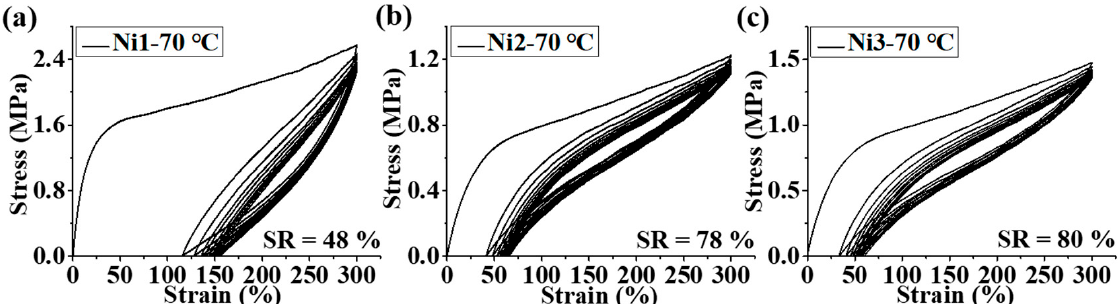
Figure 5. Hysteresis experiment plots of polyethylene samples produced by Ni1-3 at 70 °C for ten cycles at 300% strain ( a – c ).